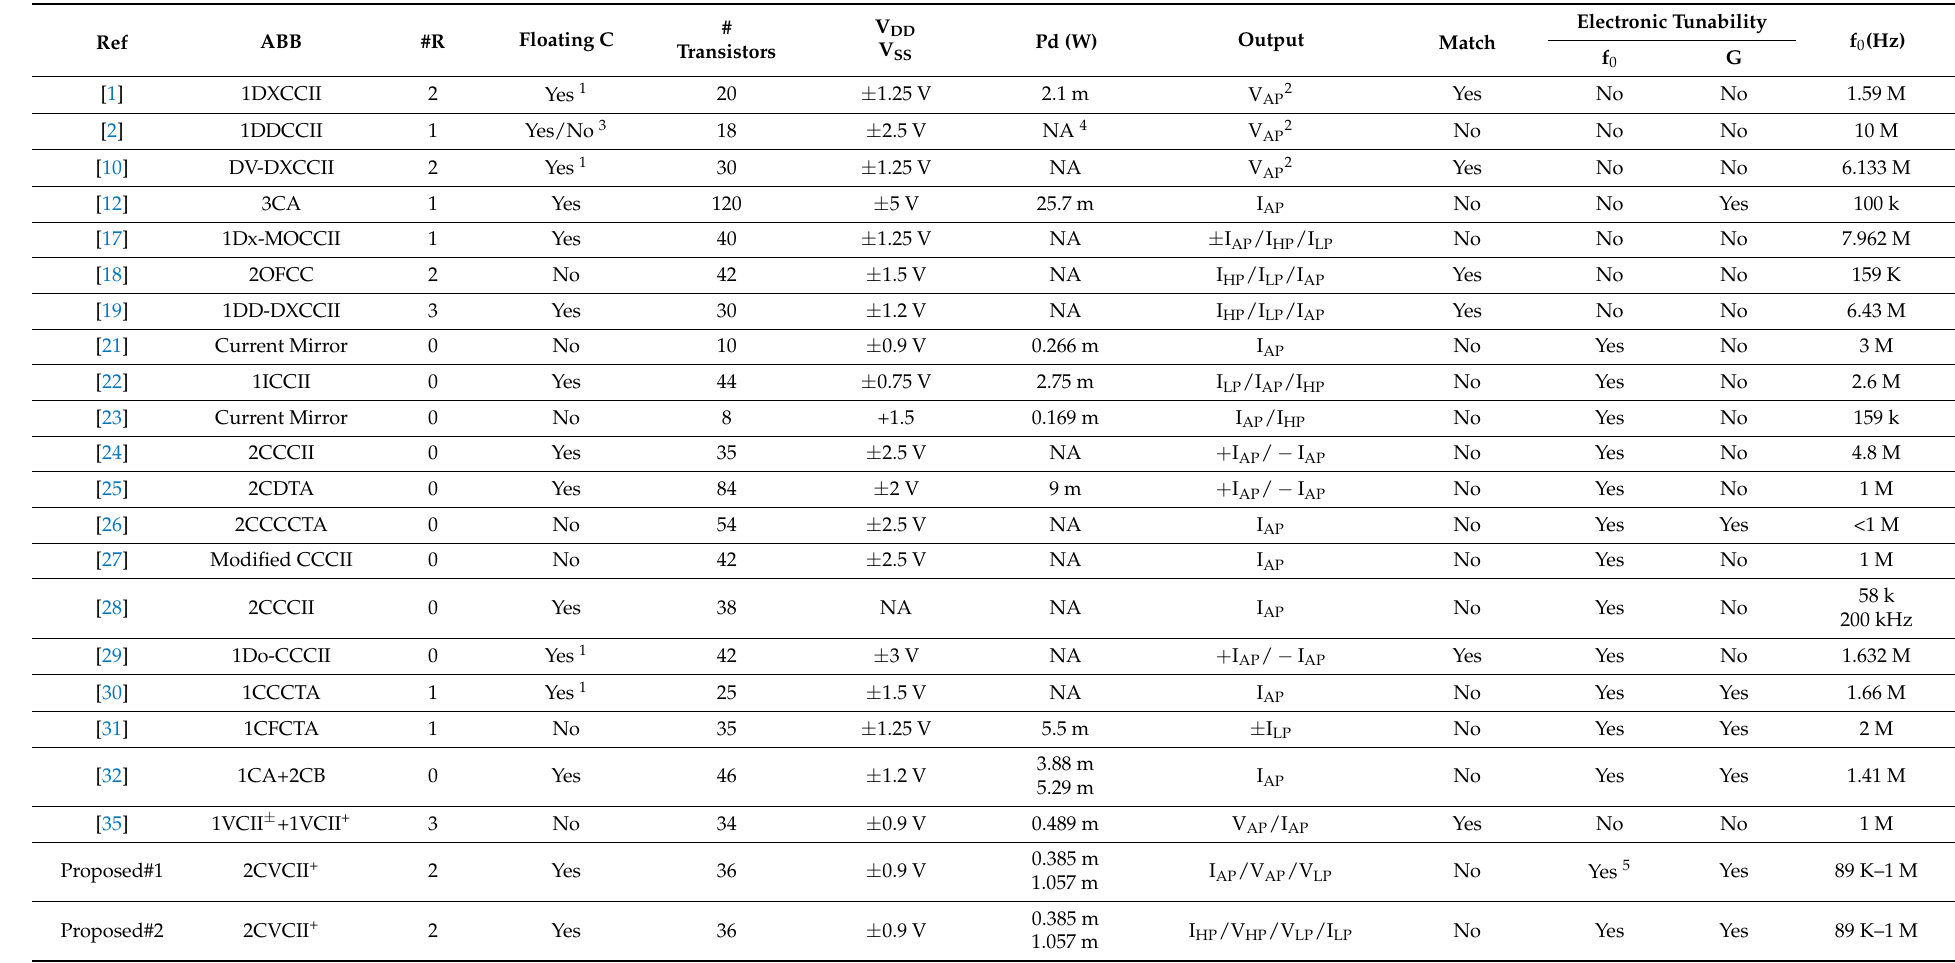
Table 3. Comparison between proposed circuit and other circuits reported in the